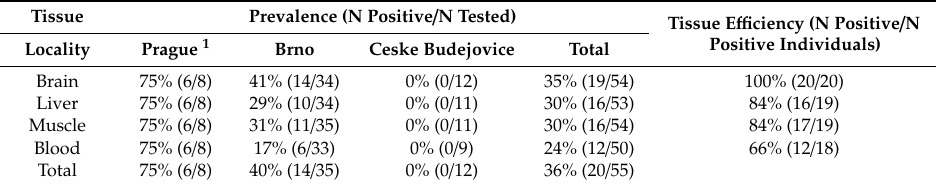
Table S3. None of the 10 song thrushes ( T. philomelos ) were positive for flavivirus RNA. Table 2. Detection of Usutu virus RNA by one-step RT-PCR in tissue samples of blackbird ( Turdus merula ) cadavers. Prevalence indicates percentage of positive samples out of tested. Not all tissue samples were available for all individuals mostly due to tissue damage. Thus, tissue e ffi ciency is expressed as a proportion of positively tested samples of a particular tissue from all positive individuals with that tissue